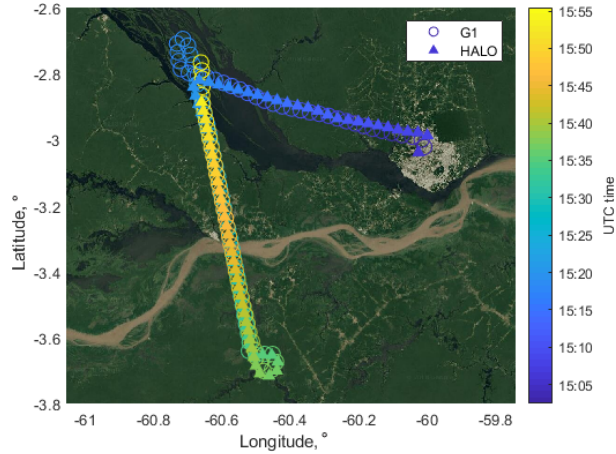
Figure 2. Time-colored flight track of the G1 (circle) and HALO (triangle) on 9 September during a cloud-free coordinated flight at 500ma.s.l. (50m apart as the closest distance). (This figure was created using Mapping Toolbox™ © COPYRIGHT 1997–2019 by The MathWorks, Inc.) Figure 3. Time-colored flight profile of the G1 (a) and HALO (b) on 21 September, during a coordinated